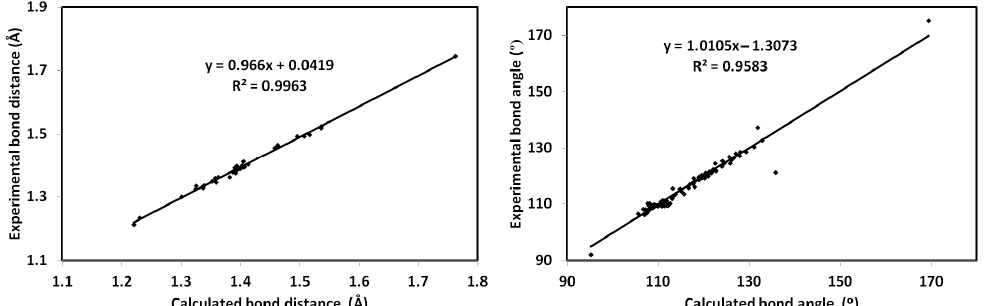
Figure 9. Correlations of the calculated and experimental geometric parameters.